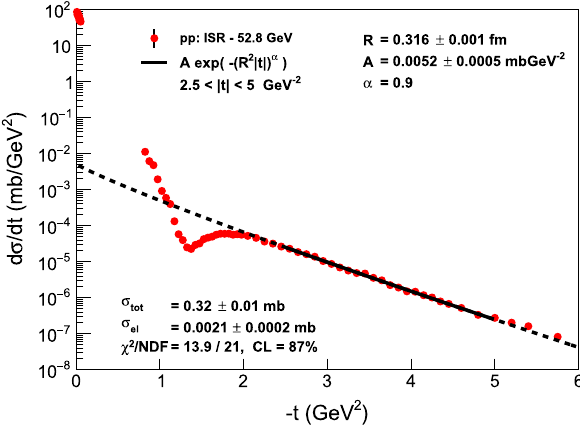
Fig. 32 Zeroth-order Lévy fits to the tail of the differential cross- section data on pp elastic scattering at fixed α = 0 . 9, A and R as free fit